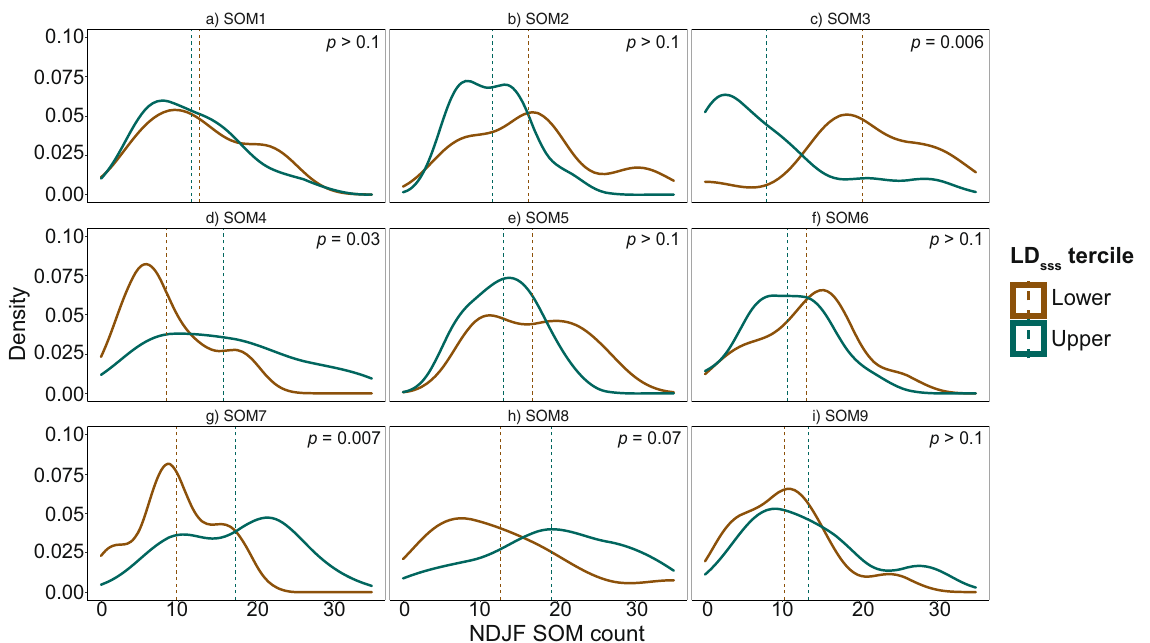
Fig. 4 Probably density curves of NDJF SOM frequency for Law Dome summertime sea-salt (LD sss ) concentration upper ( n = 13) and lower ( n = 12) tercile years and mean frequency of each group (dashed vertical line) for each SOM node in ref. 33 . SOM nodes 1 to 9 are labelled ( a – i ). The Wilcoxon signed-rank test was used to test if there was a signi fi cant difference (90%) between the mean frequency of upper/lower tercile years for each SOM node ( P < 0.1 for SOM3, SOM4, SOM7 and